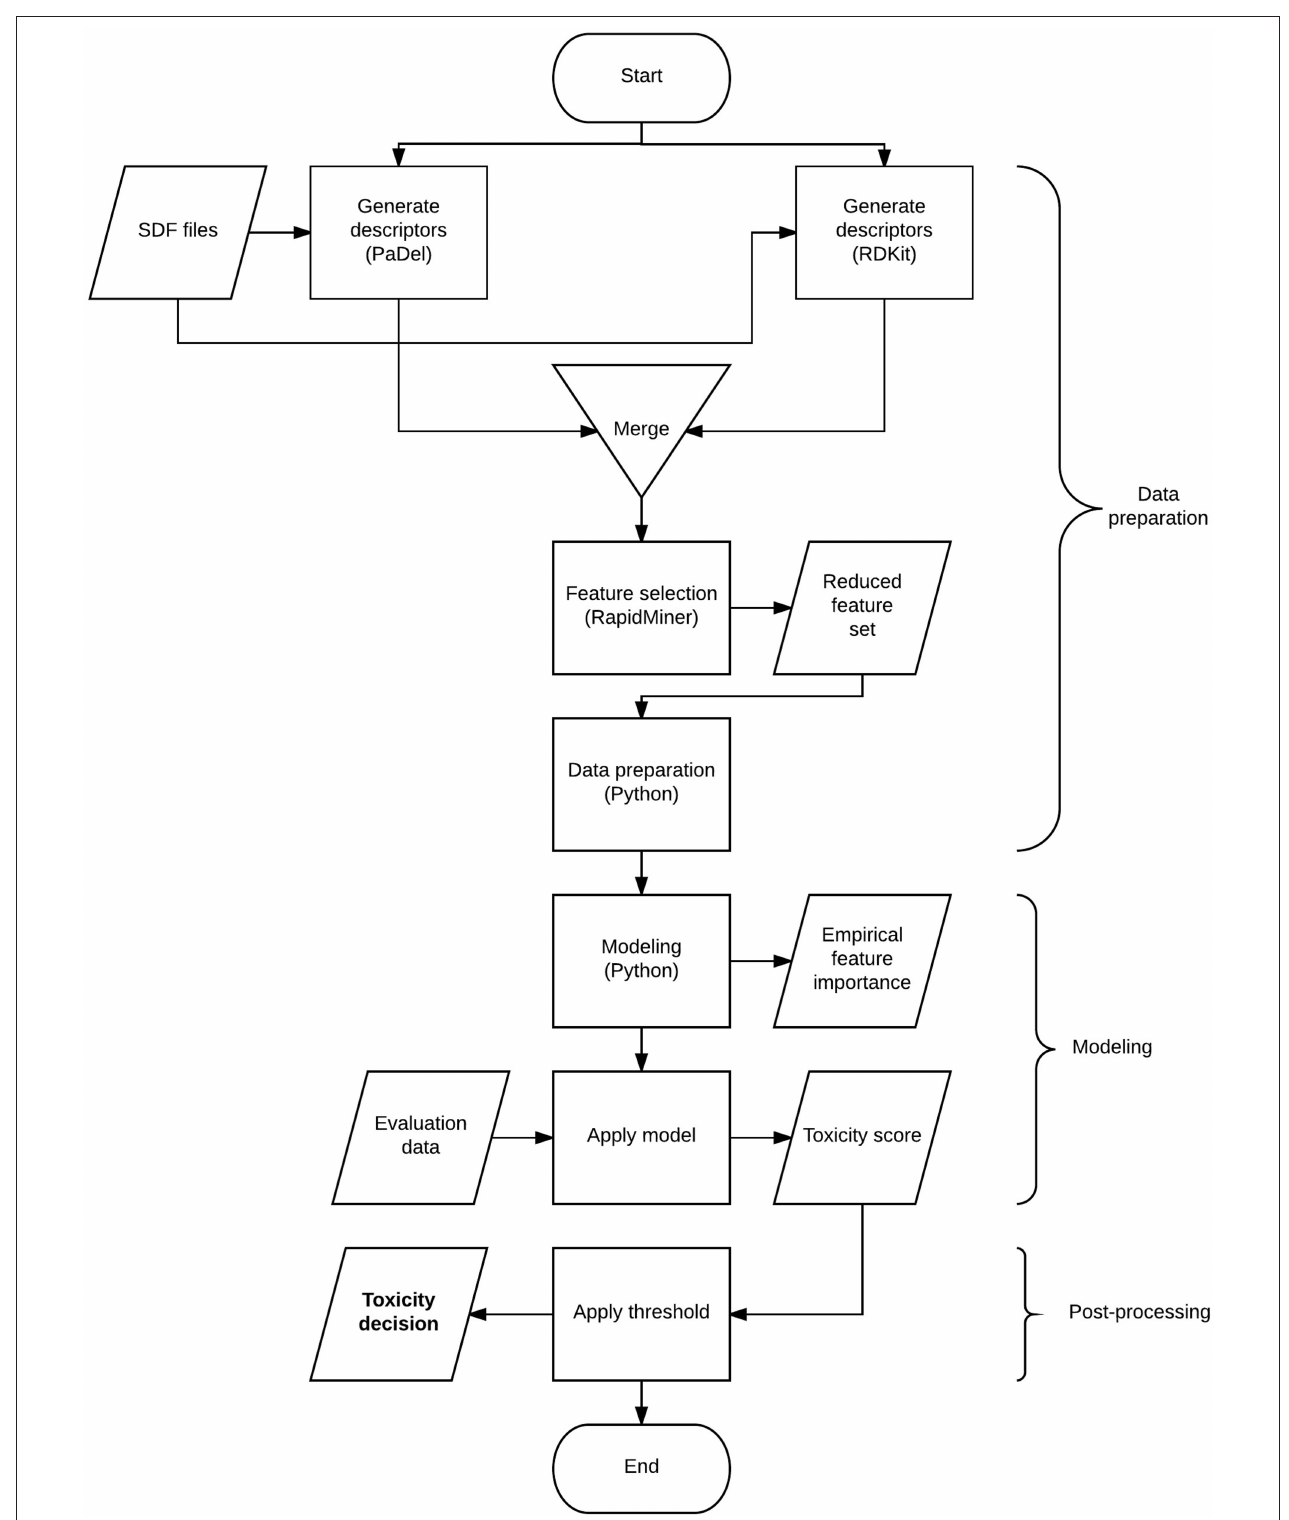
FIGURE 1 | Detailed overview of the proposed